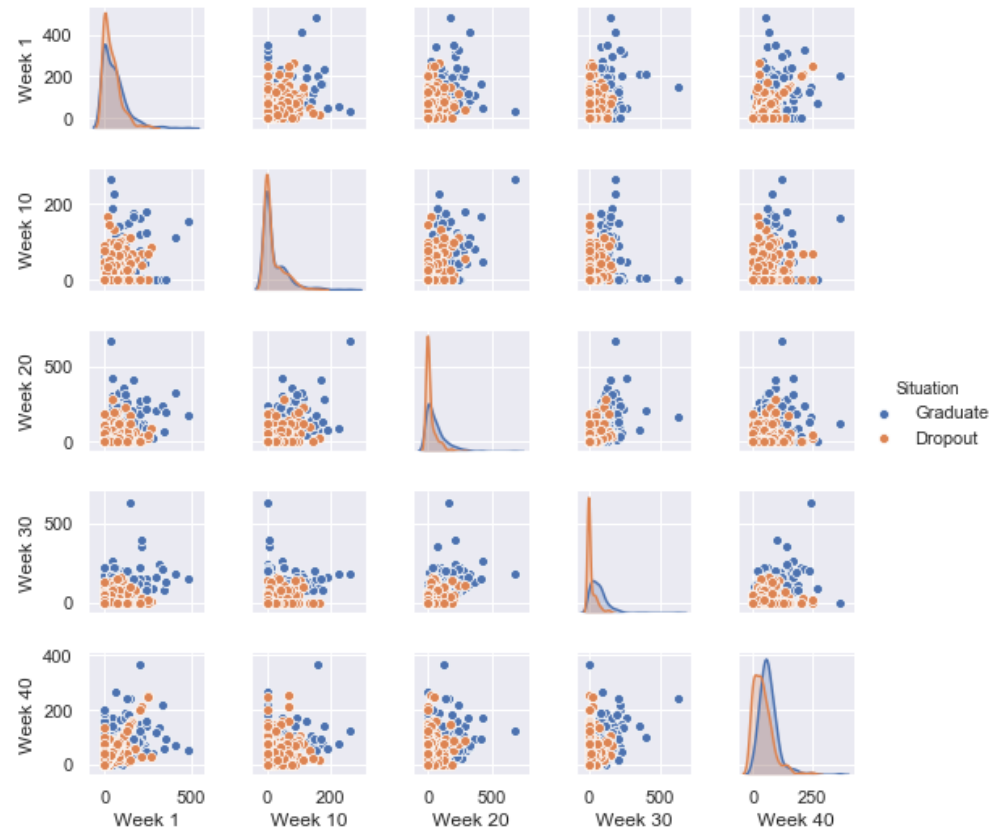
Figure 4. Density and scatter plots of weekly